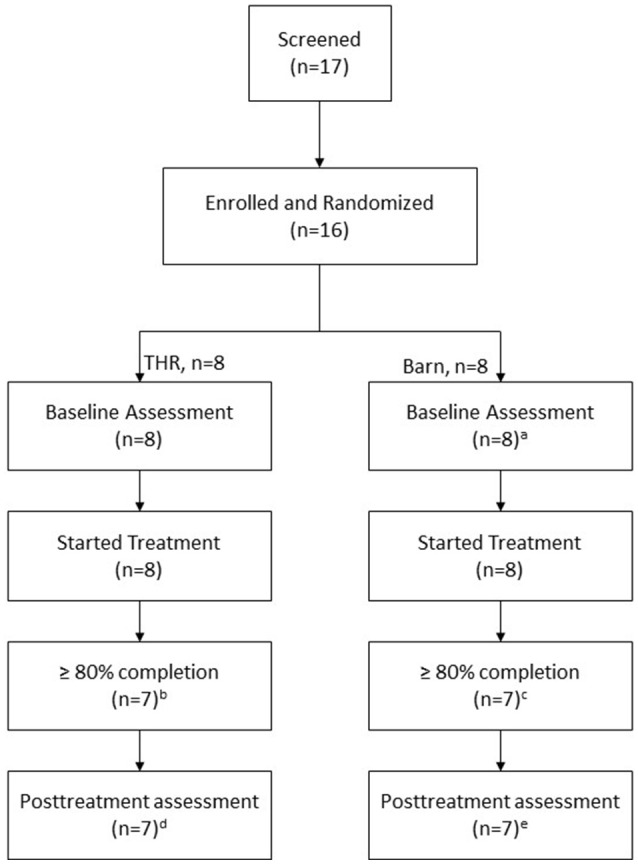
Screening, enrollment, randomization, and follow-up of study participants. aABC-C was not returned for one participant. bOne participant completed 5 sessions only. cOne participant completed 2 sessions only. dOf the 7 participants, one has no posttreatment SALT evaluation but ABC-C and SRS. eOf the 7 participants, one has no posttreatment ABC-C data but SALT and SRS.